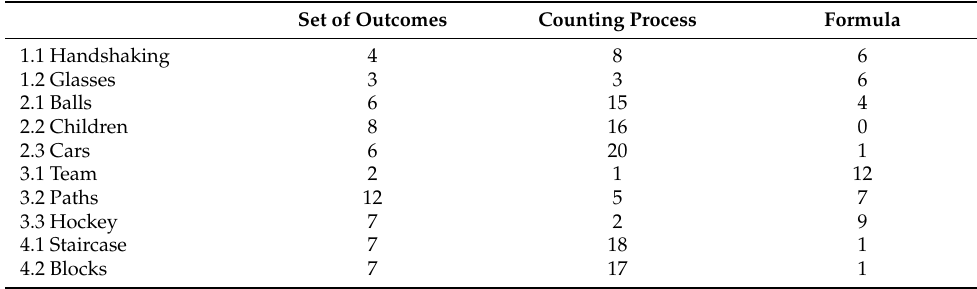
Table 3. Categorization of written solution according to the Lockwood model.